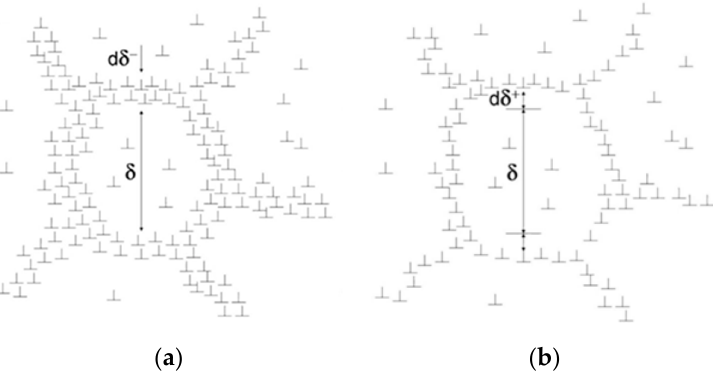
Figure 5. Schematic representation of the subgrain size evolution: ( a ) decreasing cell size due to localization of dislocations; ( b ) subgrain size growth due to dislocation climb.